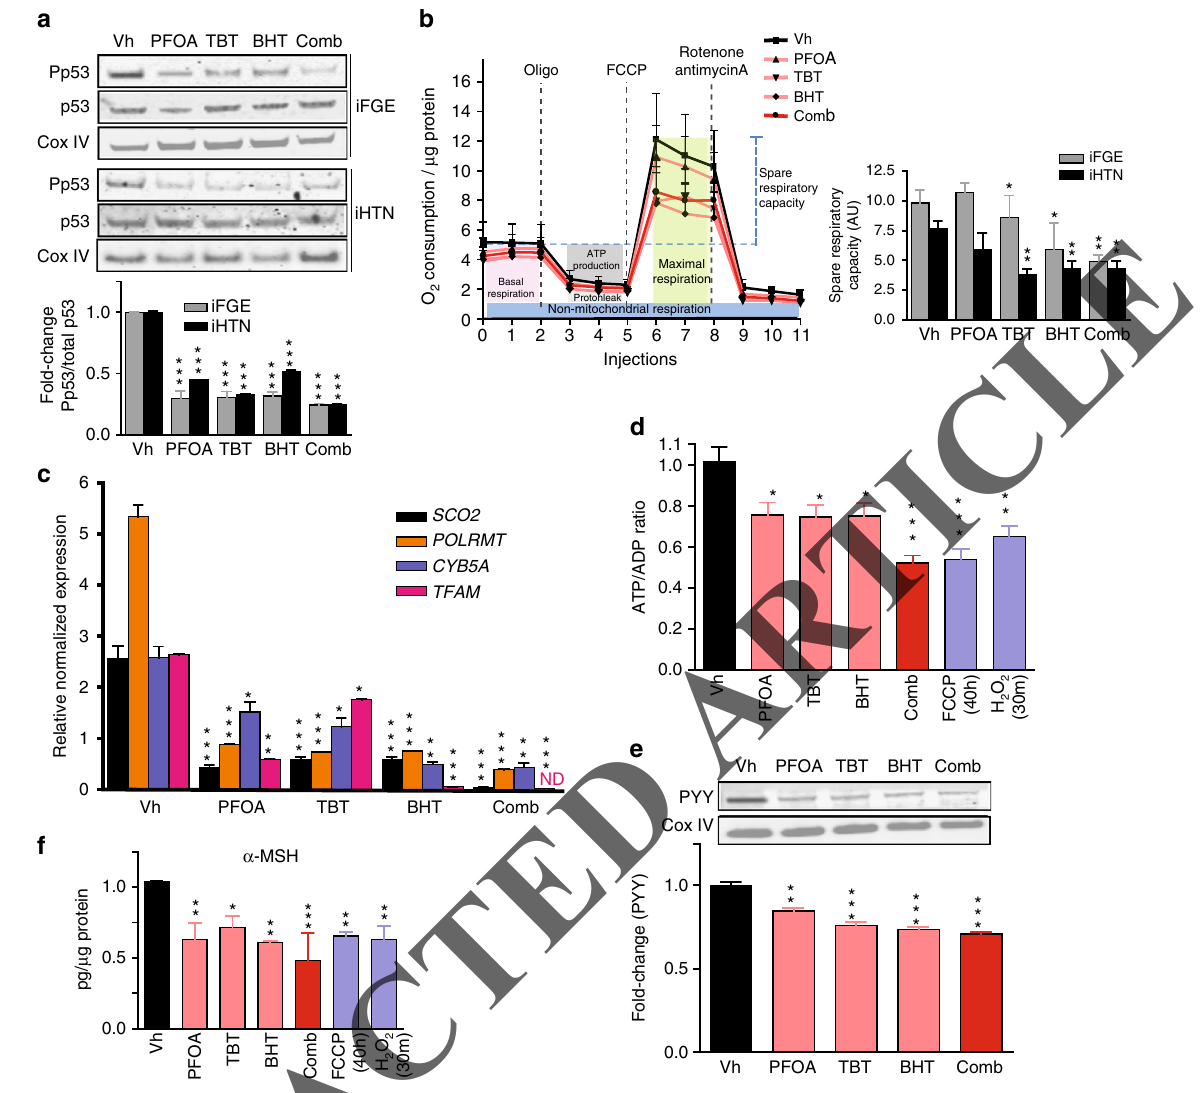
Fig. 5 EDCs induce metabolic stress and disrupt endocrine regulation. a Immunoblots showing decreases in phosphorylated p53 (Ser15) in both iFGEs and iHTNs (*** p < 0.001) upon EDC exposure. b Seahorse mitochondrial respirometry measurements with histograms representing changes in spare respiratory capacity in iFGEs and iHTNs, * p < 0.05; ** p < 0.01. c Relative normalized expression of nuclear ( SCO2, POLRMT, TFAM ) and mitochondrial- encoded ( CYB5A ) genes involved in mitochondrial respiration in iHTNs as measured by RT-qPCR. d Measurement of ATP levels (ATP/ADP ratio) showing decreases with EDC treatments. e Immunoblots showing decreases in PYY levels in EDCs-treated iFGEs. f ELISA of α -MSH showing decreases in secretion with EDC treatment of iHTNs. * p < 0.05, ** p < 0.01, *** p < 0.001, n = 3. ND not detectable. All statistical analysis was performed using one-way ANOVA. Data shown here are representative of average results from the two iPSC lines differentiated n = 3 times in independent experiments. Error bars denote